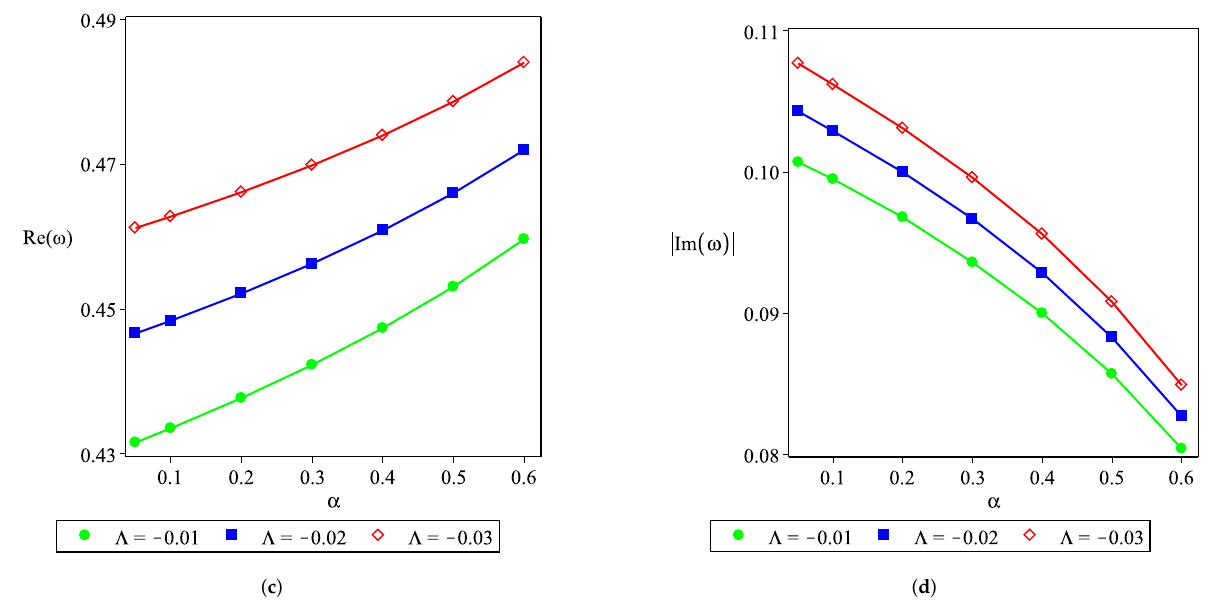
Figure 5. The behavior of Re ( ω ) and Im ( ω ) with the GB parameter for M = 1, n = 0, L = 2 and different values of k (Figure 5a,b) and Λ (Figure 5c,d). See the text for more details. ( a ) Λ = − 0.02; ( b ) Λ = − 0.02; ( c ) k = 0.2; ( d ) k =